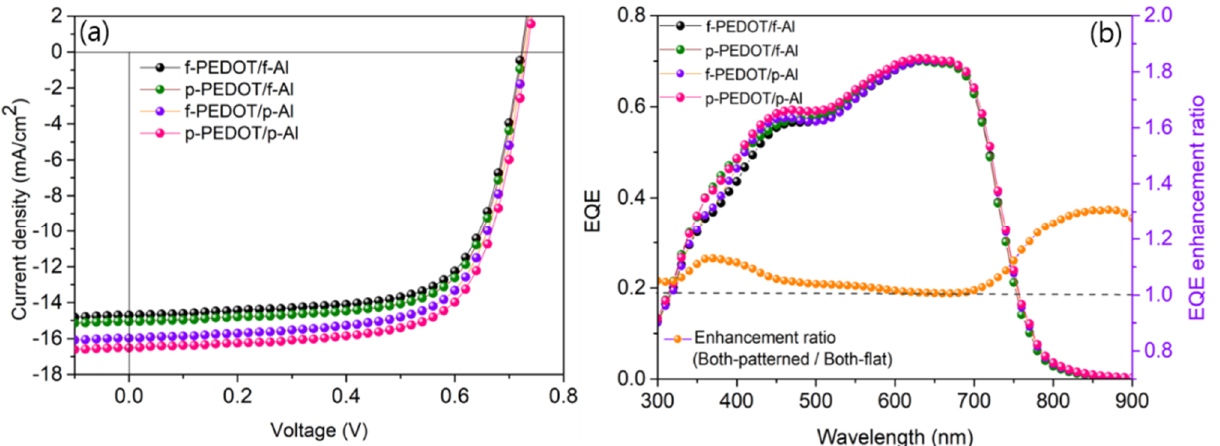
Figure 4. J-V characteristics of ultra-flexible OPVs based on PTB7:PC 71 BM BHJ with ( a ) f-PEDOT/f-Al, p-PEDOT/f-Al, f-PEDOT/p-Al, and p-PEDOT/p-Al. J-V characteristics of UFOPVs measured under AM 1.5G illumination at 100 mW cm −2 . ( b ) EQE spectra and EQE enhancement ratios of the patterned devices relative to the reference.